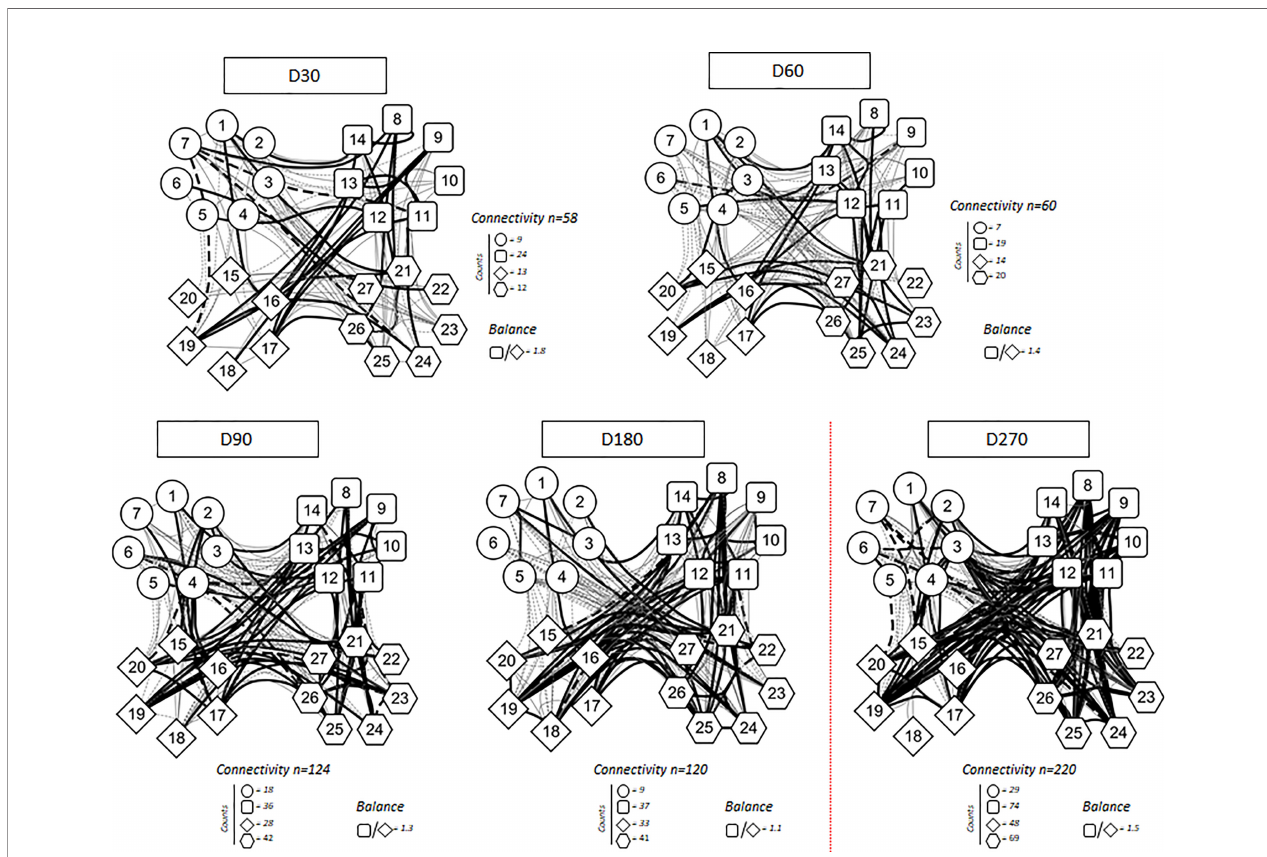
FIGURE 6 | Correlation analysis presented as a network of immunological chemokines (O), pro-in fl ammatory cytokines ( □ ), regulatory cytokines ( ◊ ), and growth factors ( ) over the time after vaccination. Each parameter is shown in a node. Red dotted lines represent booster dose timepoint. Statistical analysis was performed using the Spearman correlation test and the signi fi cant correlations (p < 0.05) are represented by a line connecting both nodes. The correlation was classi fi ed as weak (r < 0), moderate (0.36 < r < 0.68) and strong (r > 0.68), based on absolute value of correlation index r, represented by line thickness. Thick and thin connecting edges represent strong and moderate correlation between soluble mediators, respectively. Positive correlation is expressed by a continuous line, while negative correlation by dashed lines. Number of connectivity and balance between pro-in fl ammatory and regulatory cytokine are